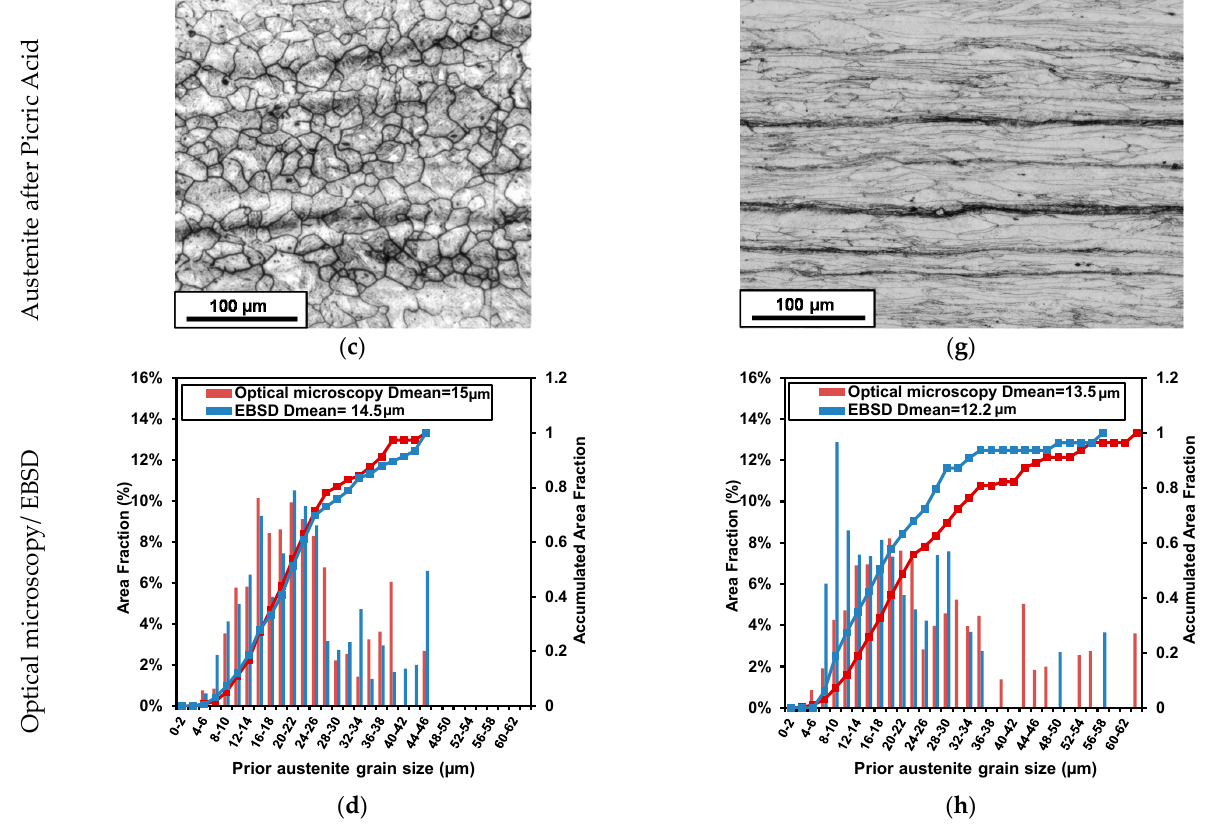
Figure 5. ( a , e ) Martensitic microstructure, ( b , f ) reconstructed austenite by electron backscattered diffraction (EBSD), ( c , g ) optical images corresponding to austenite obtained after picric acid, ( d , h ) austenite size distributions measured by optical microscopy and EBSD technique for ( a – d ) CMnB and ( e – h ) CMnNbMoB steels (Applied strain direction, equivalent to rolling direction (RD), is considered for Inverse Pole Figure (IPF) representation).